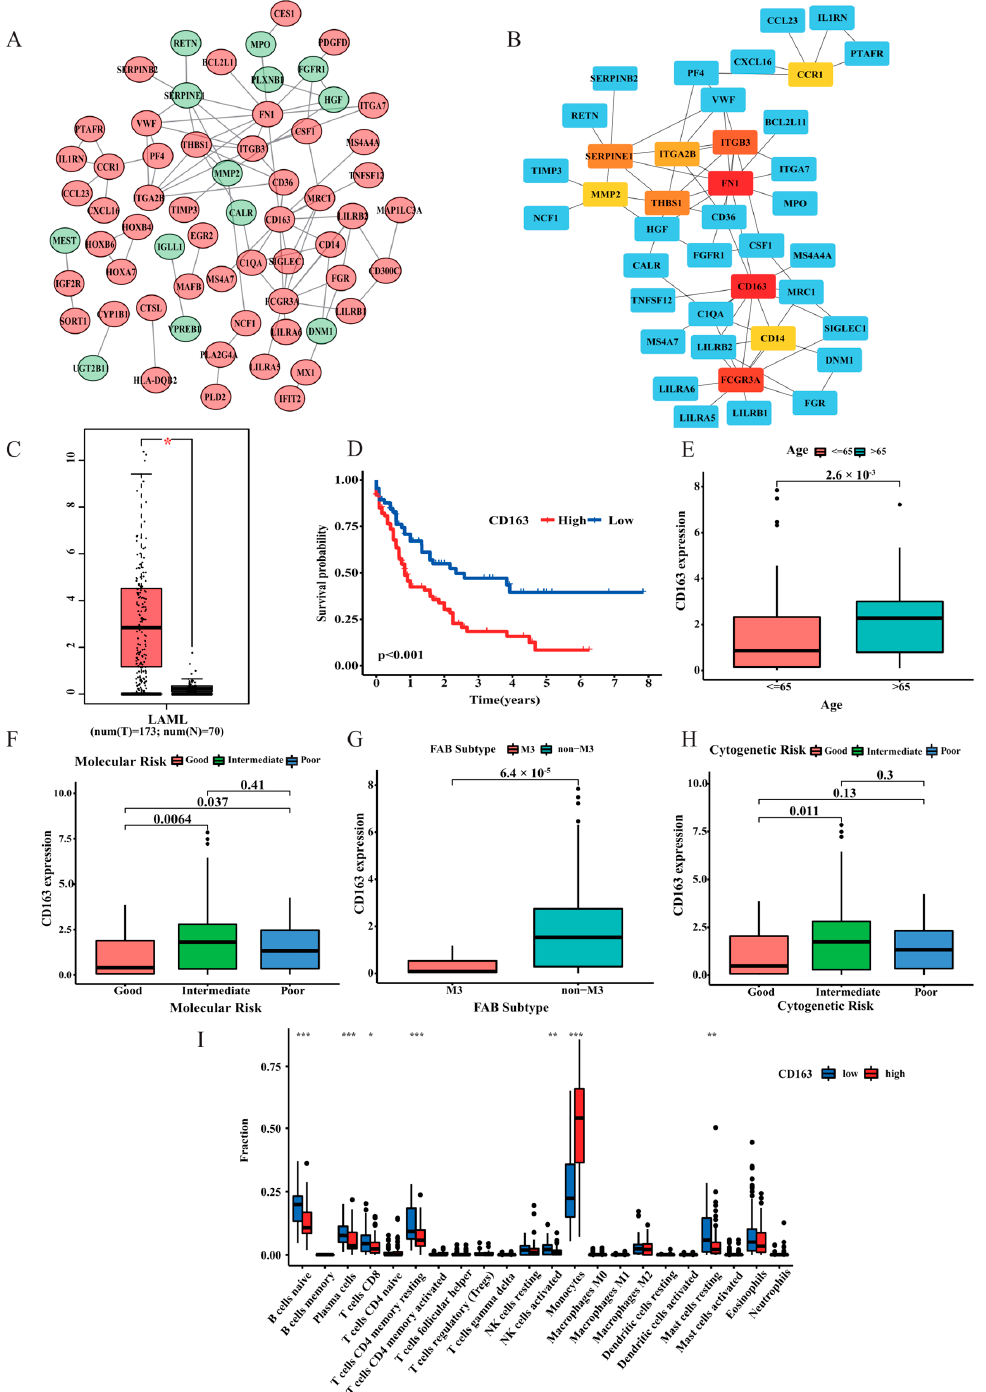
Figure 10. Protein ‒ protein interaction (PPI) network. ( A ) PPI network processed by Cytoscape. Upregulated genes in the high-risk score group are marked in red, and those in the low-risk score group are presented in green. ( B ) Top 10 hub genes selected by cytoHubba. ( C ) The expression of CD163 genes in AML patients and paired normal bone marrow samples was analyzed by GEPIA. ( D ) Survival analysis for the subgroup classified by CD163 mRNA expression. ( E – H ) The CD163 mRNA expression levels differed among different groups based on clinical features, including age,